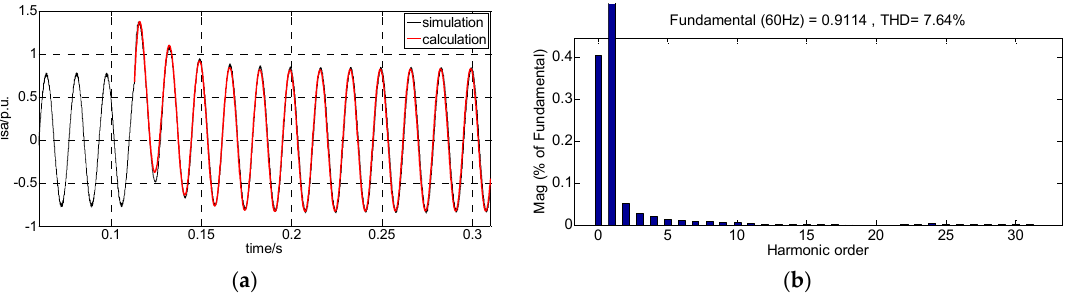
Figure 10. Stator short-circuit current and its frequency spectral analysis: ( a ) comparison between simulated and calculated waveform; ( b ) frequency spectral analysis.